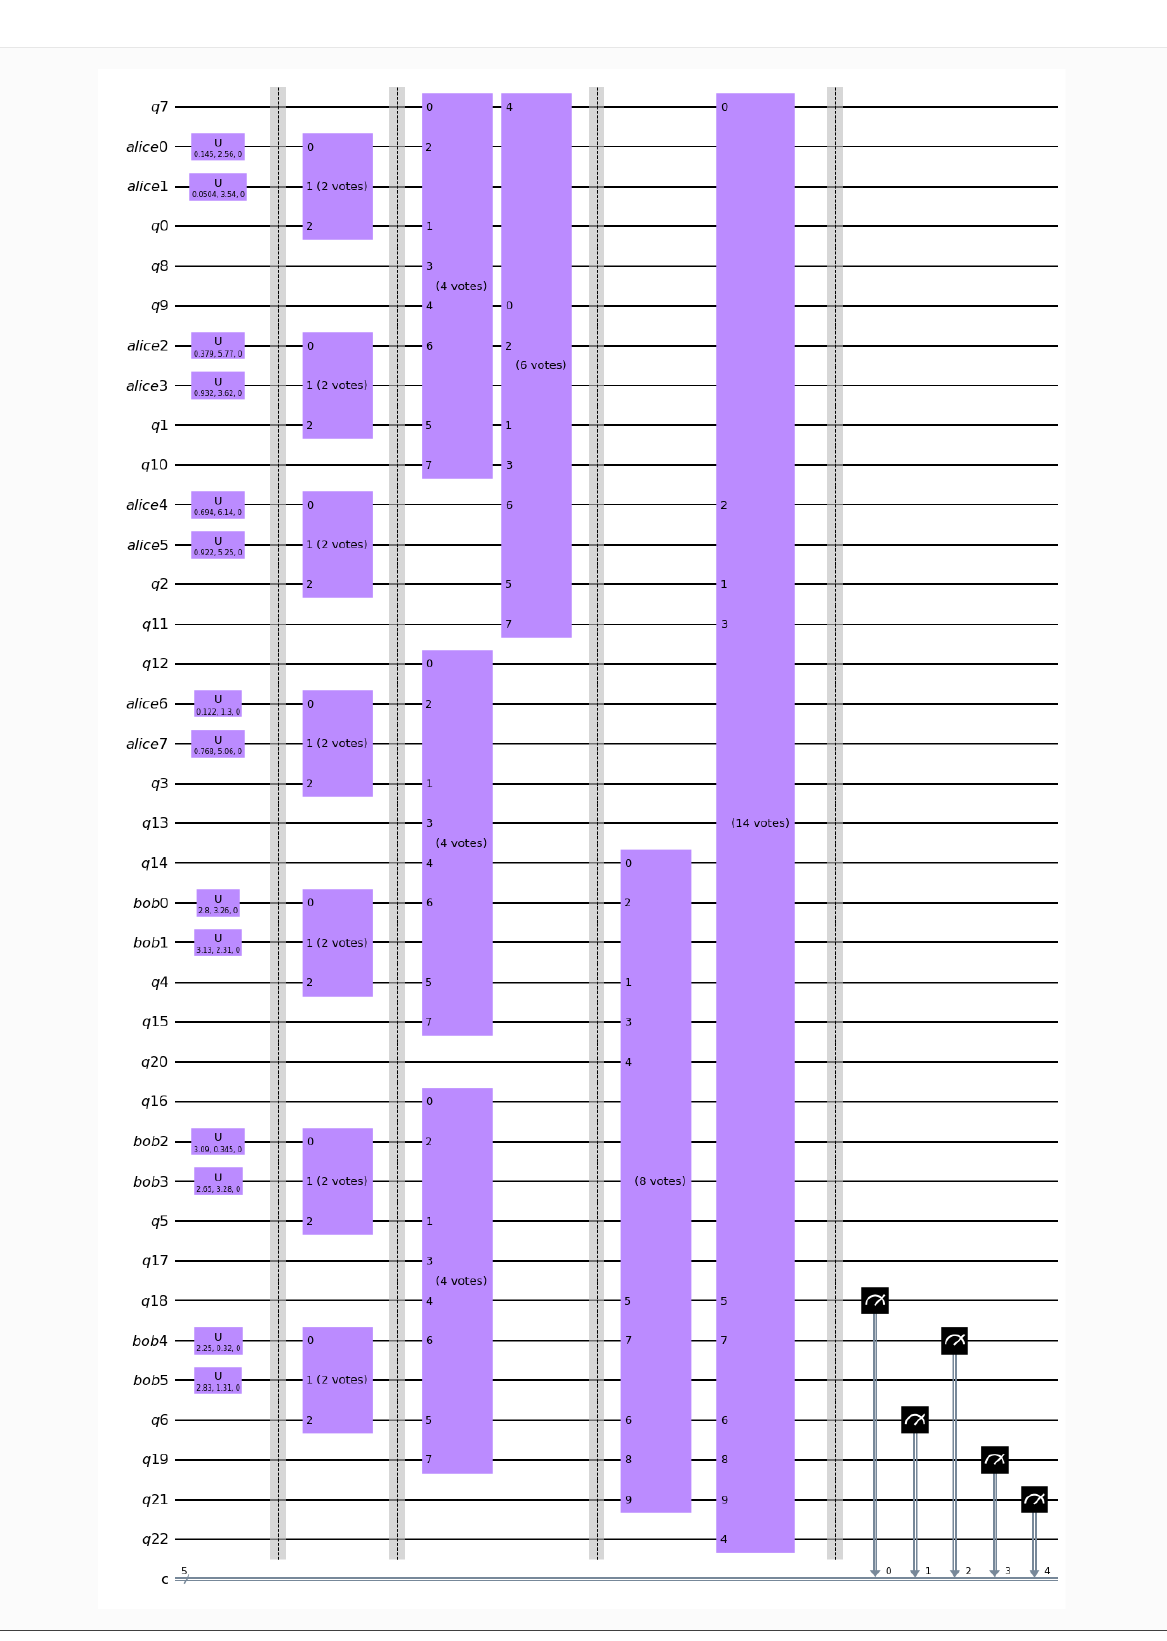
Figure 2. The circuit for simulating the quantum voting process in a parliament of 14 legislators, where Alice and Bob’s parties have 8 and 6 representatives respectively.